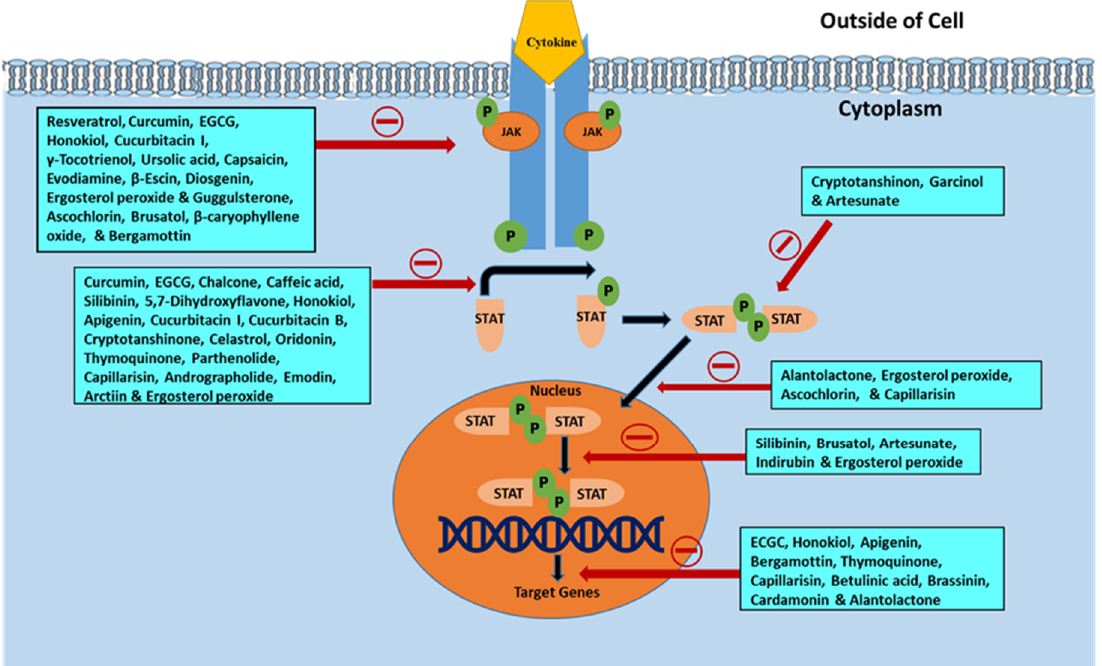
Figure 5. Illustration of various phytochemicals blocking specific steps in the JAK/STAT signaling pathway in relation to their cancer preventive and anticancer actions.